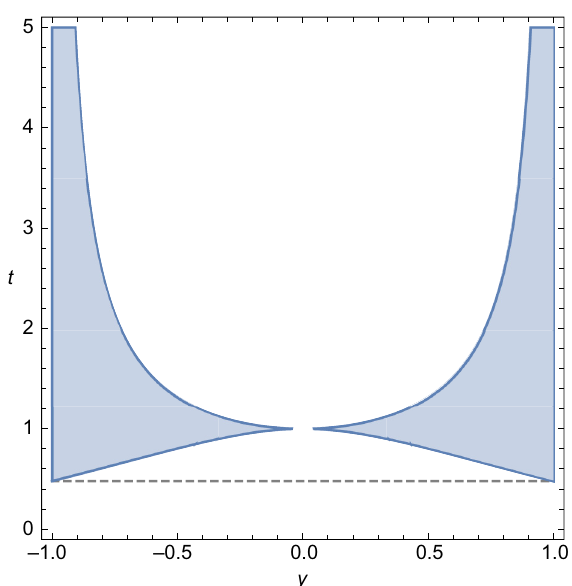
FIG. 5. The filled region corresponds to the set of parame- ters ( y , t ) for which Alice’s measurements ( σ X and y σ Y ) are > 1 = β( M (cid:17) ) . Note that ): (cid:2) A (cid:2) Bell nonlocal (for the game M (cid:17) √ M (cid:17) t t t for t > t ∗ = ( 9 − 4 2 )/ 7, the game M (cid:17) does not allow quan- t tum violations when Alice’s measurements are of the form A = σ ) . (σ X , y Y